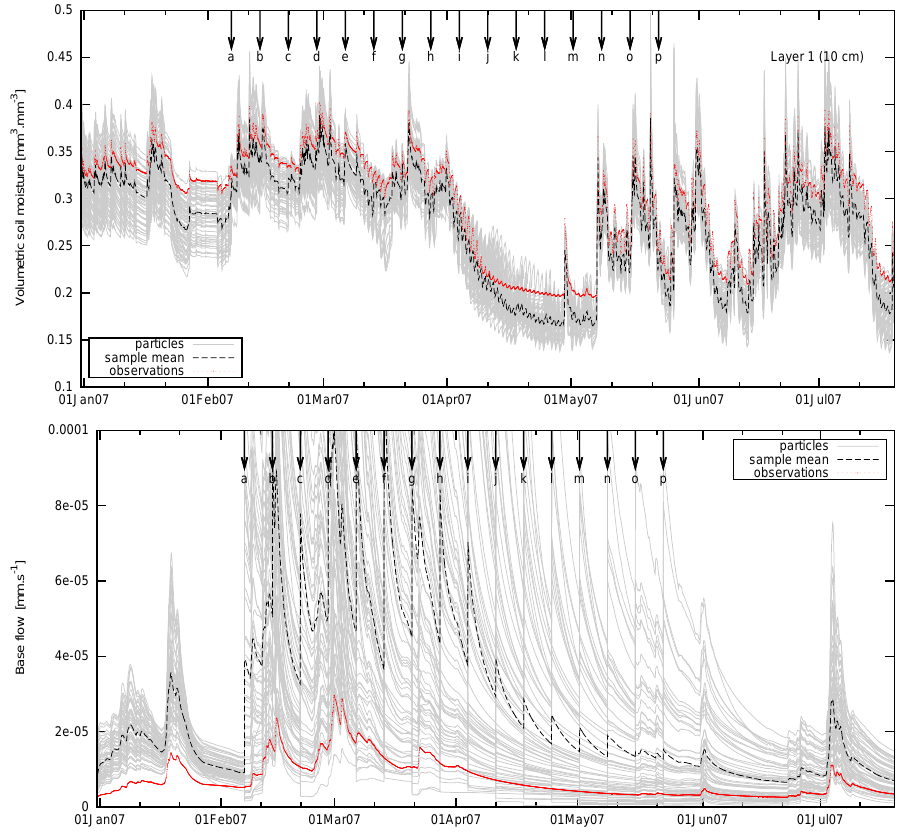
Fig. 5. SISR filter performance and assimilation impact on the baseflow. The soil moisture and baseflow time series correspond to the DA study performed with set 2 as the initial parameter set.